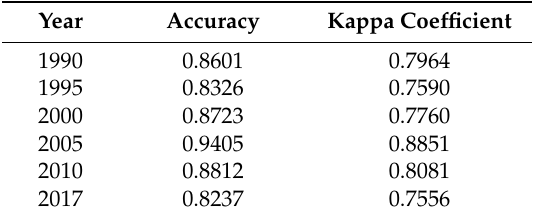
Table 5. Accuracy assessments of multi-temporal RF models.